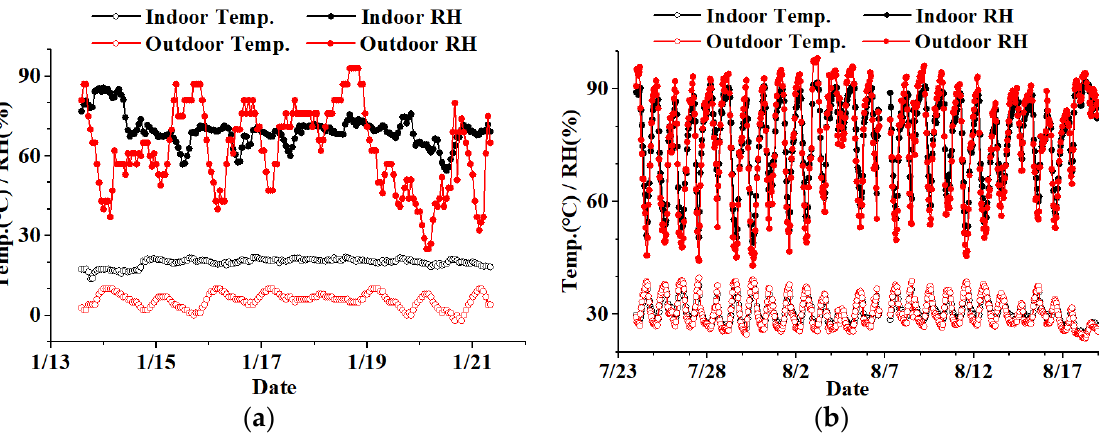
Figure 2. Temporal variation of air temperature and relative humidity inside and outside the nursery house. ( a ) Winter; ( b ) Summer.